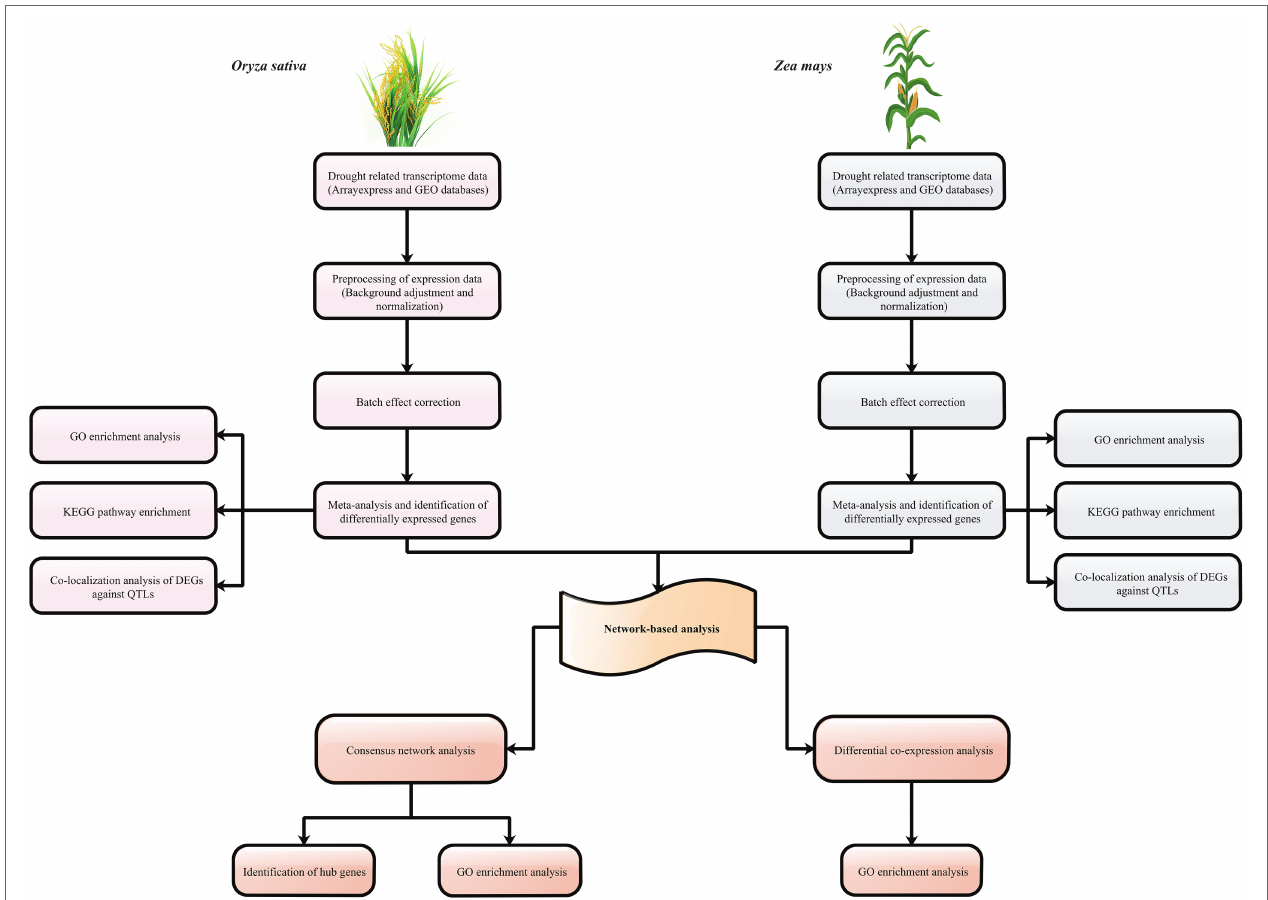
FIGURE 1 | Schematic overview of the strategy for understanding the aspects of C 3 and C 4 plants to drought